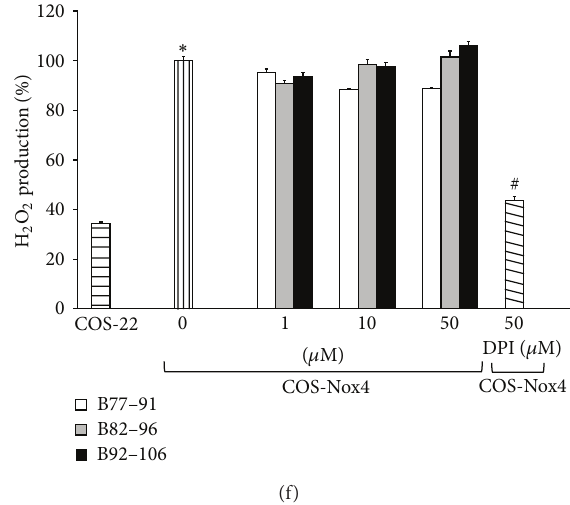
Figure1:Nox4B-looppeptidesandNox4activity.(a)AsimplifiedmodelofNox4oxidasewithB-andD-loopslocatedintracellularly.p 22 𝑝ℎ𝑜𝑥 , theonlyknownproteinrequiredforNox4activity,isalsoshown.(b)AminoacidsequenceofNox4B-loopandlistofoverlappingNox4B-loop region synthetic 15-mer and nonamer peptides used to target Nox4 activity. The numbers at the N- and C-terminus of each peptide indicate the location of the corresponding residues in the amino acid sequence of Nox4. (c) H 2 O 2 generated by Nox4 was measured using Amplex Red fluorescence. H 2 O 2 production was initiated by the addition of 36 𝜇 M NADPH. The reaction was monitored at 24 ∘ C for 40min. The flavin-containing enzyme inhibitor diphenyleneiodonium (DPI; 50 𝜇 M) was used as a positive control. Identification of H 2 O 2 was confirmed by inhibition of fluorescence with catalase (3000U/mL). For comparison, H 2 O 2 production in nontransfected COS-22 cell lysate is shown. Data represent the mean ± SEM of 3 experiments. ∗ 𝑃 < 0.05 indicates significant difference between COS-22 and COS-Nox4 cell lysates. (d) COS-Nox4 cell lysates were preincubated with various concentrations of B90–98 (from 0.1 to 100 𝜇 M) for 15min at 24 ∘ C, and H 2 O 2 was measured using Amplex Red fluorescence. Data represent the mean ± SEM of 3 experiments. (e) COS-Nox4 cell lysates were preincubated with the R96E mutant version of B90–98 (PSRRTR E LL; 0.3 to 30 𝜇 M) for 15min at 24 ∘ C, and H 2 O 2 was measured. Data represent the mean ± SEM of 3 experiments. (f) COS-Nox4 cell lysates were preincubated with peptides from N- and C-terminal ends of the Nox4 B-loop (B77–91, B82–96, and B92–106; 1 to 50 𝜇 M) for 15min at 24 ∘ C, and H 2 O 2 was measured. Data represent the means ± SEM of 3 experiments. ∗ 𝑃 < 0.05 indicates a significant difference between COS-22 and COS-Nox4 cell lysates. # 𝑃 < 0.05 indicates a significant difference between COS-Nox4 + 0 𝜇 M peptide and COS-Nox4 +